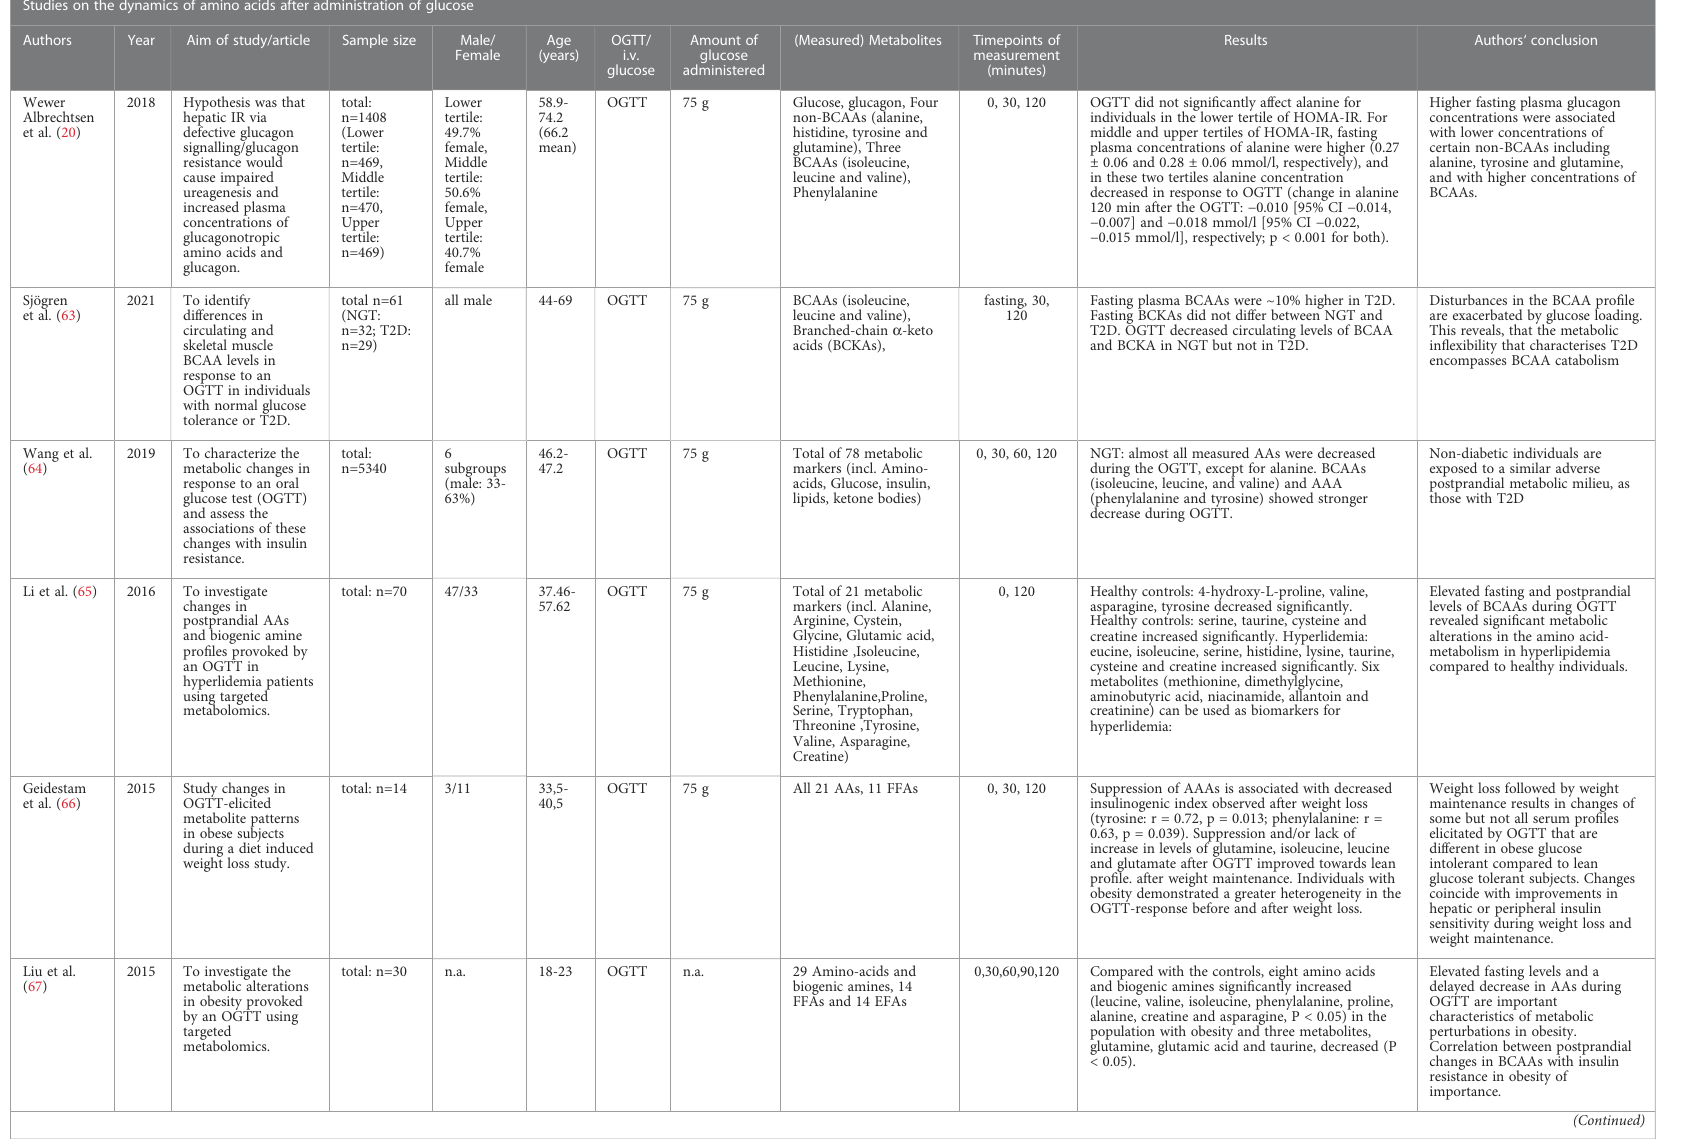
TABLE 2 Studies on the dynamics of glucagon after administration of glucose. Studies on the dynamics of amino acids after administration of glucose Authors